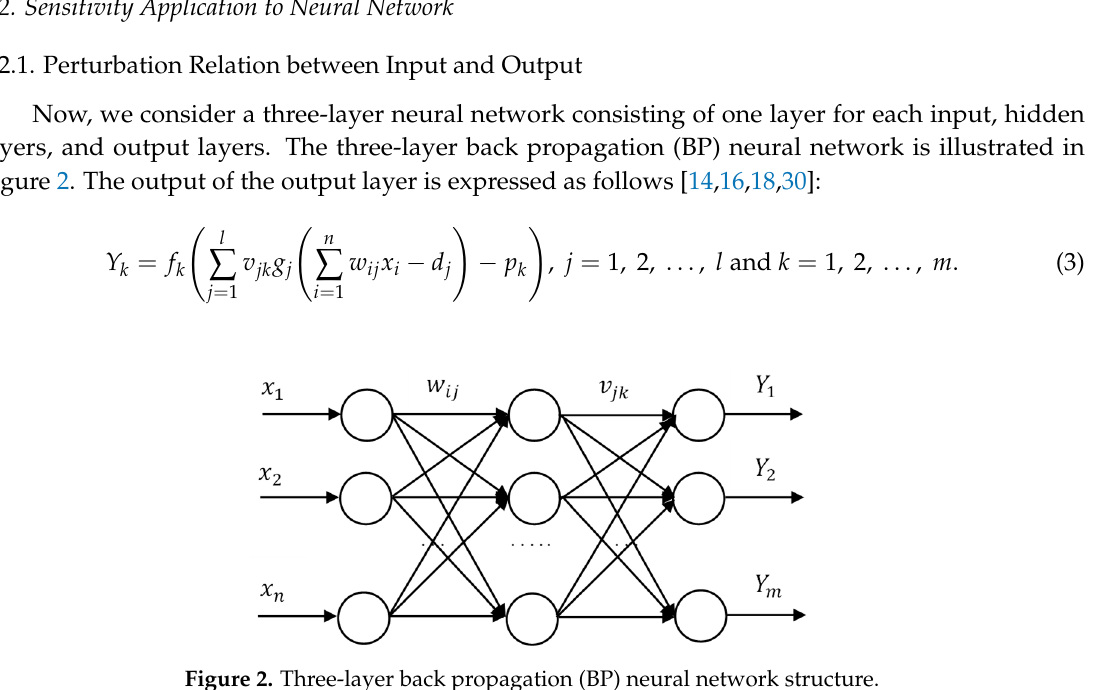
Figure 2. Three - layer back propagation (BP) neural network structure. Figure 2. Three-layer back propagation (BP) neural network